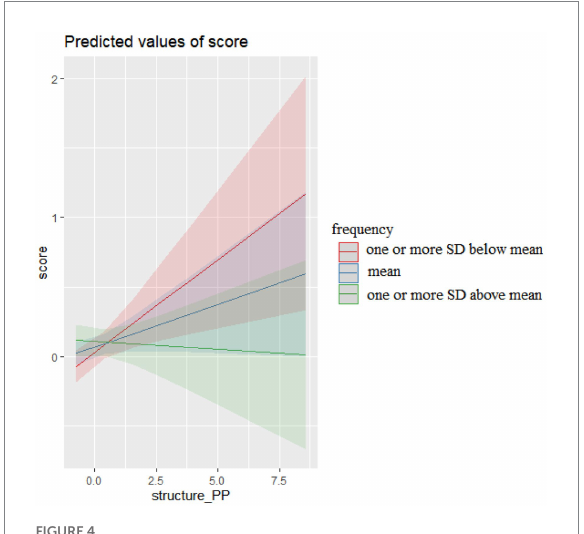
FIGURE 4 The interaction effects of PP sequences and frequency on essay scores.